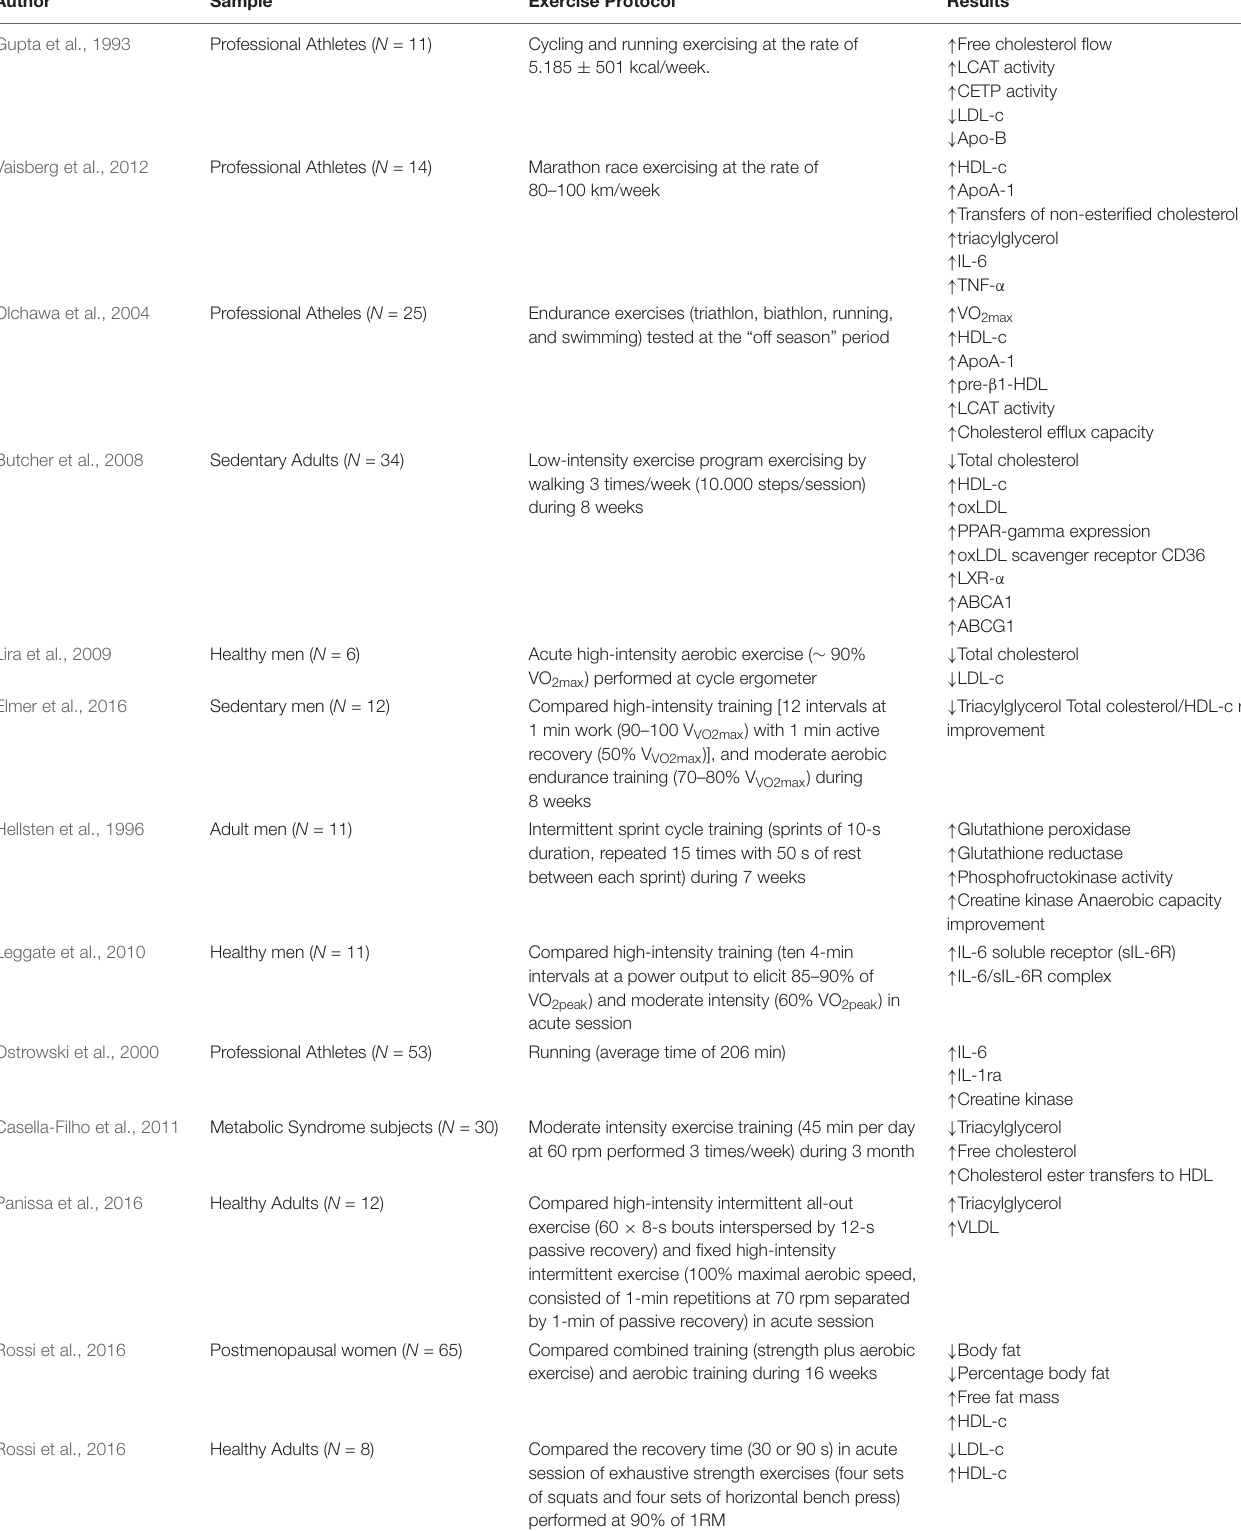
TABLE 1 | Clinical evidence of the effect of training strategies on metabolic and lipid